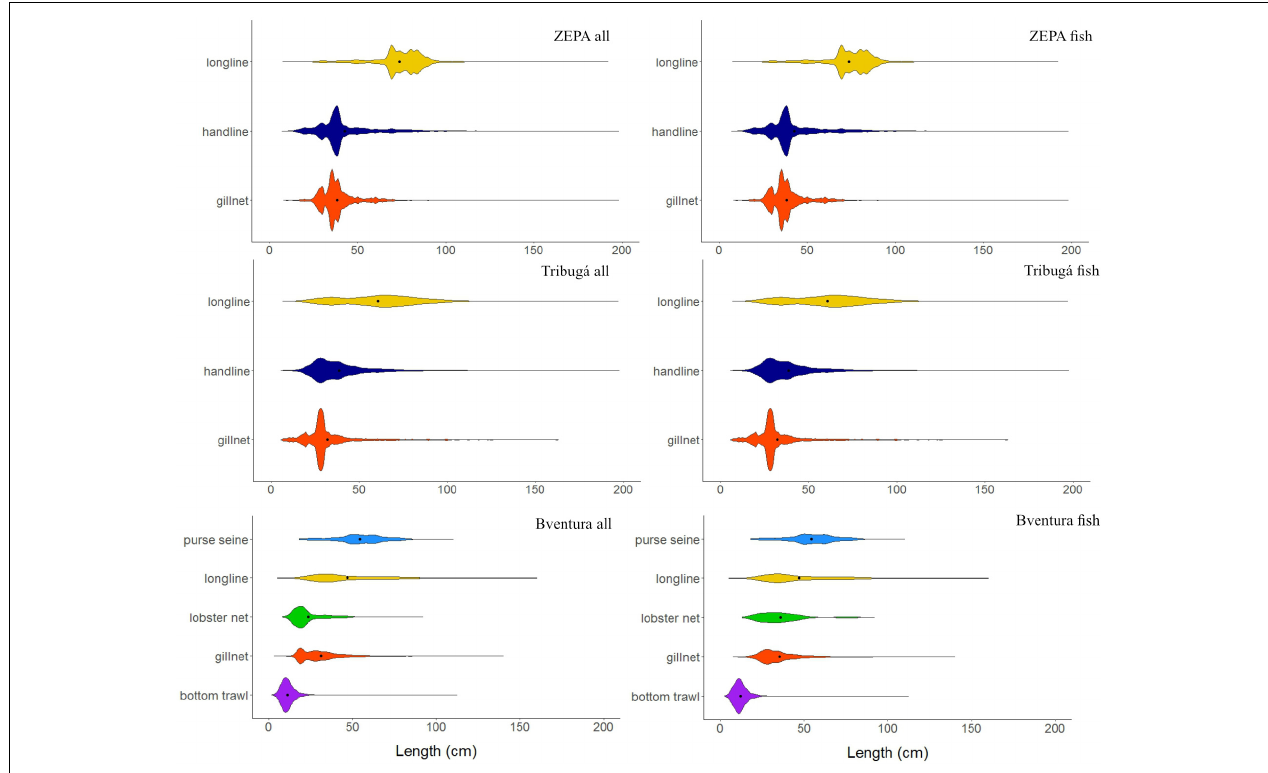
FIGURE 4 | Length distribution of the entire catch (up to 200 cm) and of the fish portion of the catch of SSF per gear type at three coastal zones of the Colombian Pacific: ZEPA, Tribugá, and Buenaventura (abbreviation: Bventura). Black dots indicate mean values. A similar plot of the length distribution of the catch up to the maximum length observed at each zone is included as part of the Supplementary Figure S3